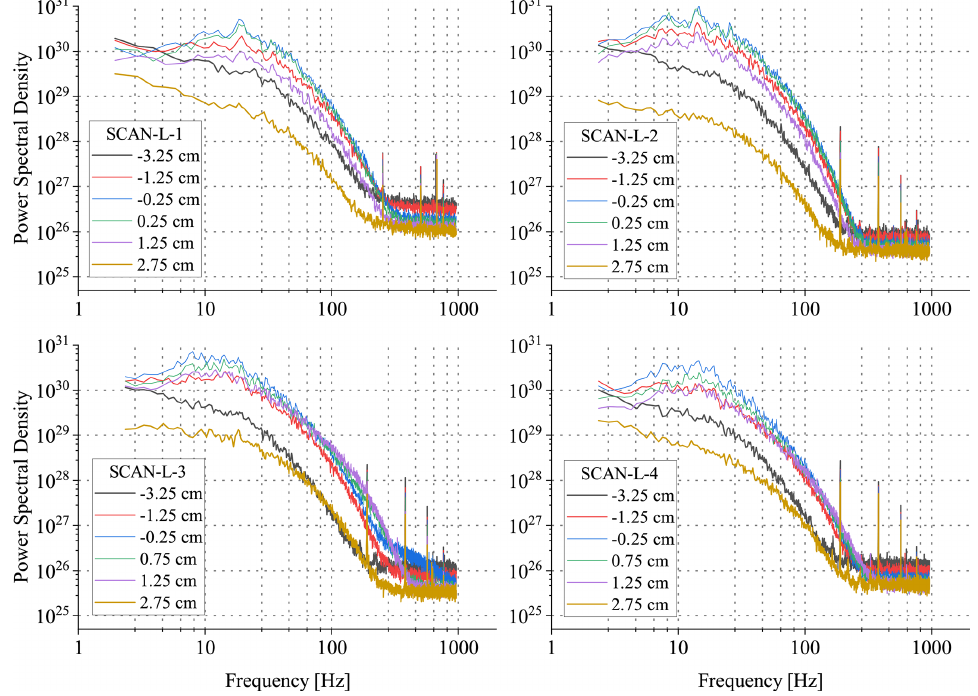
Figure 10. Power spectral densities of the selected time series n(t) recorded at various positions x during the four scans.